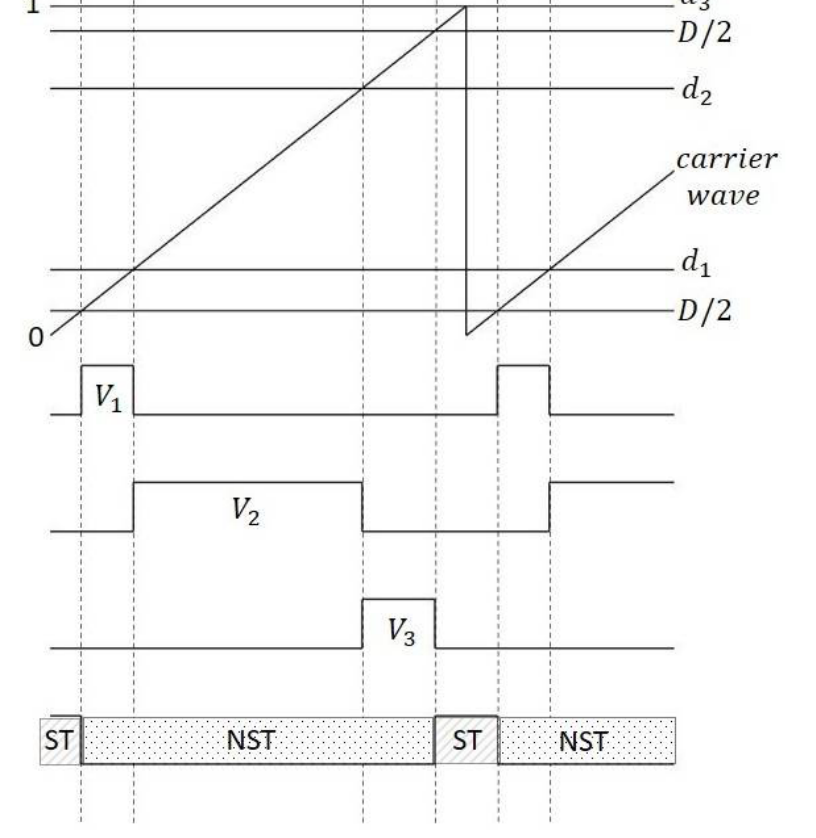
Figure 4. SVPWM strategy for qZSI Filter.